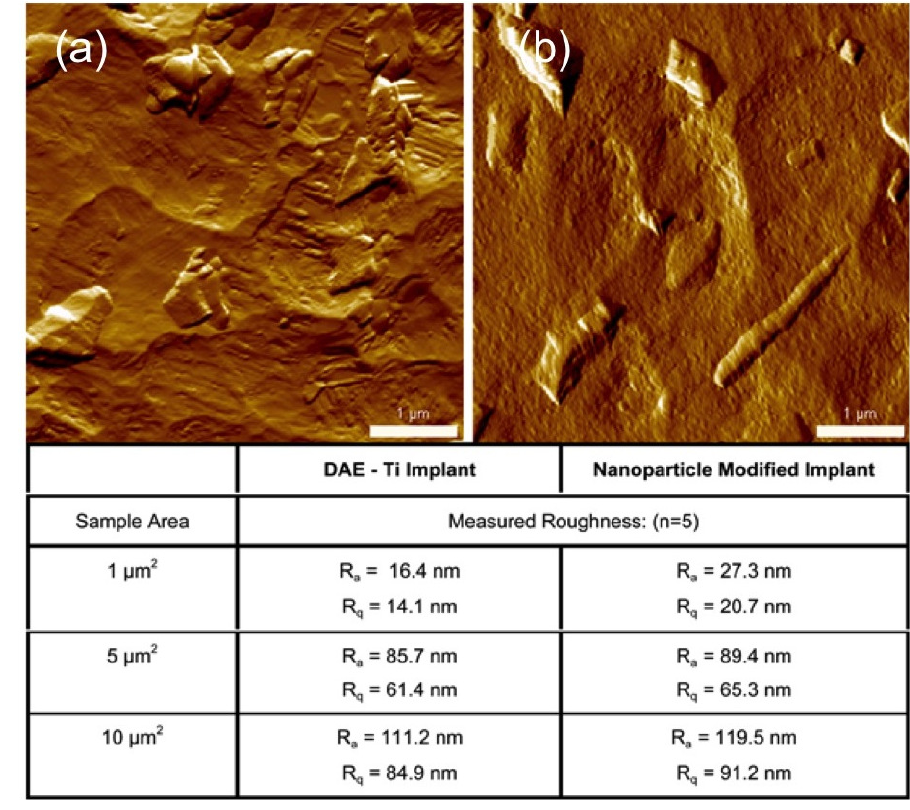
Figure 8. ( a ) AFM height images and surface roughness analysis showing variations in nanoscale topography between dual-acid-etched (DAE) titanium implant surface titanium before deposition of discrete hydroxyapatitenanoparticles. ( b ) After deposition